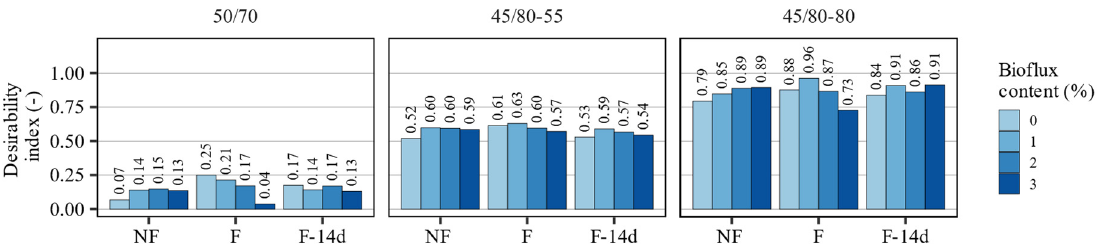
Figure 11. The desirability indices calculated using the multivariate optimization methodology.